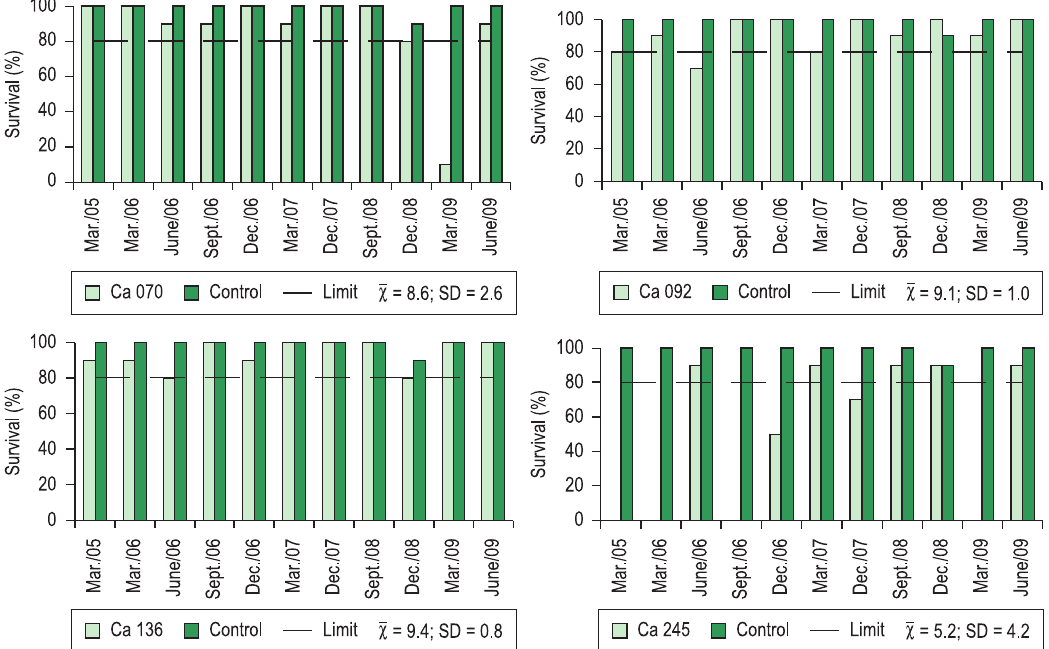
Figure 2. Survival comparison, mean and standard deviation in Daphnia magna exposed to Caí River sediment samples, control group and expected survival from Mar./2005 to June/2009.